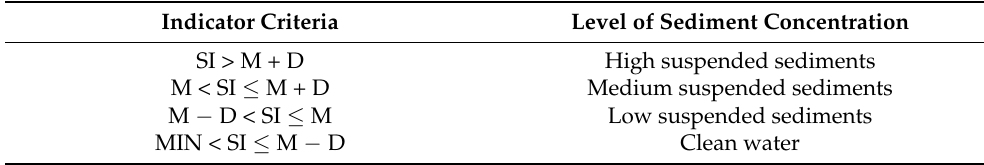
Table 2. Level of sediment concentration in water